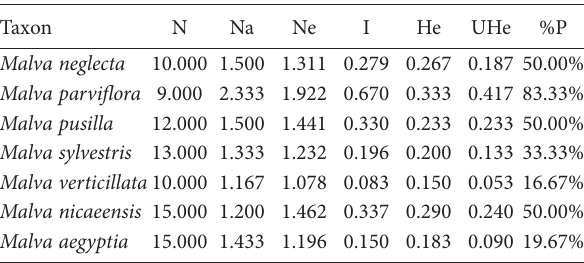
Table 3. Genetic diversity variables of Malva (N = number of sam- ples, Na= number of different alleles, Ne = number of effective alleles, I= Shannon’s information index, He = gene diversity, UHe = unbiased gene diversity, P%= percentage of polymorphism in popu- lations).